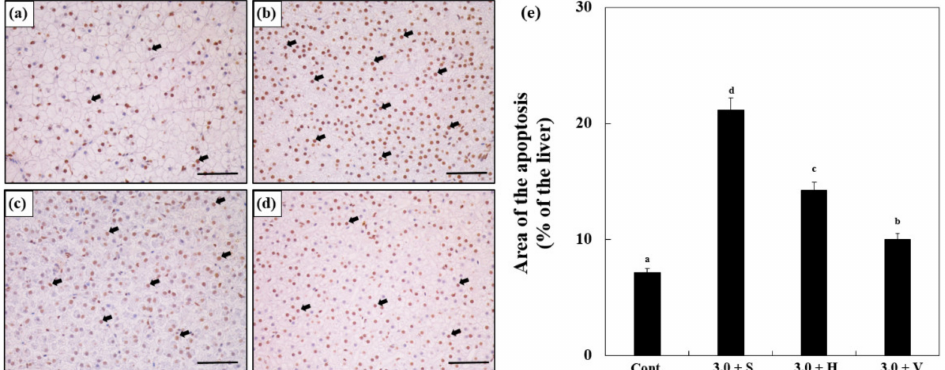
Figure 6. Images from a terminal deoxynucleotidyl transferase dUTP nick end labeling (TUNEL) assay using the liver cells of goldfish in the experiment for ( a ) control, ( b ) Zn 3.0 + S, ( c ) Zn 3.0 + H, and ( d ) Zn 3.0 + V. Brown cells indicate apoptotic cells. Scale bars = 200 µ m. ( e ) Quantification of TUNEL assay images of the liver cells of goldfish exposed to different Zn concentrations and water hardness levels, which are indicated by the changes in the areas of apoptosis relative to the tissue area (%). Different letters indicate significant differences among goldfish exposed to different Zn concentrations and water hardness levels for the same duration. ( p < 0.05). Values indicate means ± SD ( n =